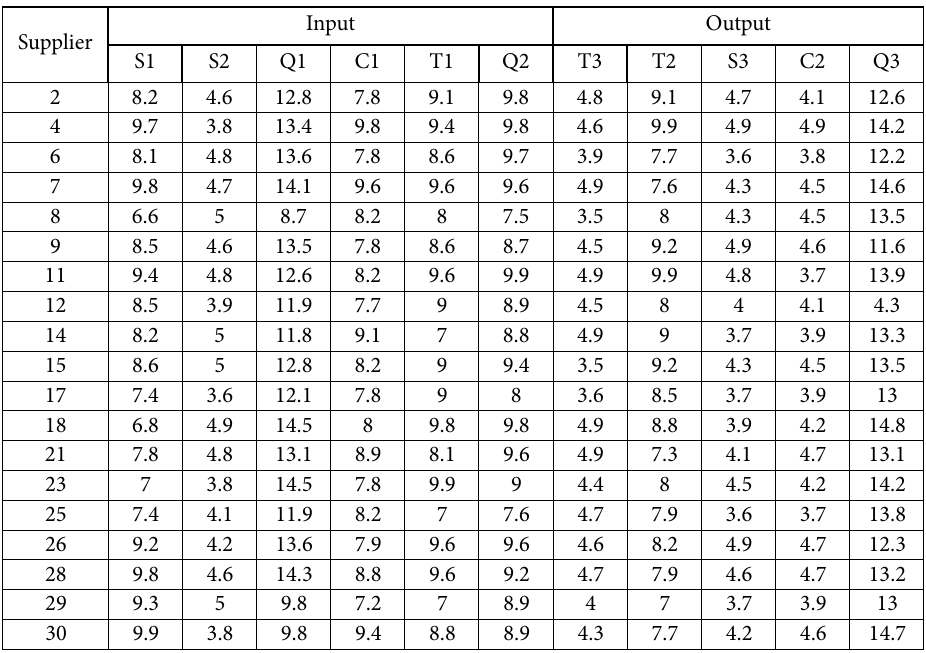
Table 24. Original inputs and outputs data for oxygen sensor